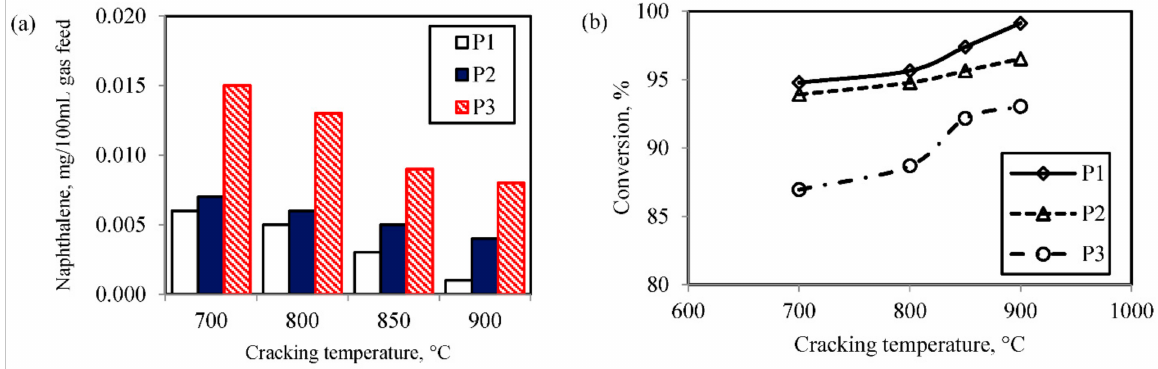
Figure 7. Effect of different catalyst to biomass (C/B) ratio on ( a ) naphthalene concentration ( b ) naphthalene